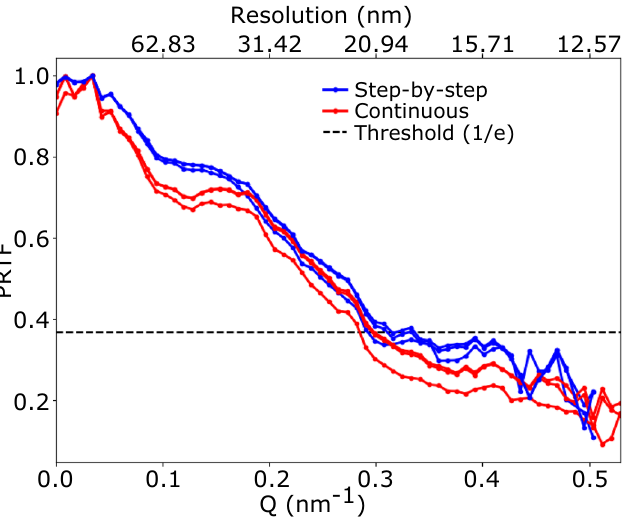
Figure 5. Spatial resolution. Estimation of the spatial resolution using phase retrieval transfer function (PRTF) for three sets of reconstructions obtained from the step-by-step and continuous scanning